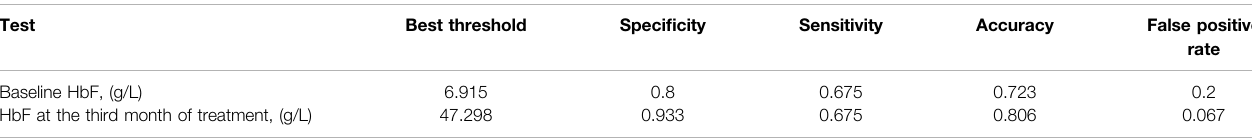
Abbreviation: HbF, fetal hemoglobin; ROC, receiver-operating characteristic curve.